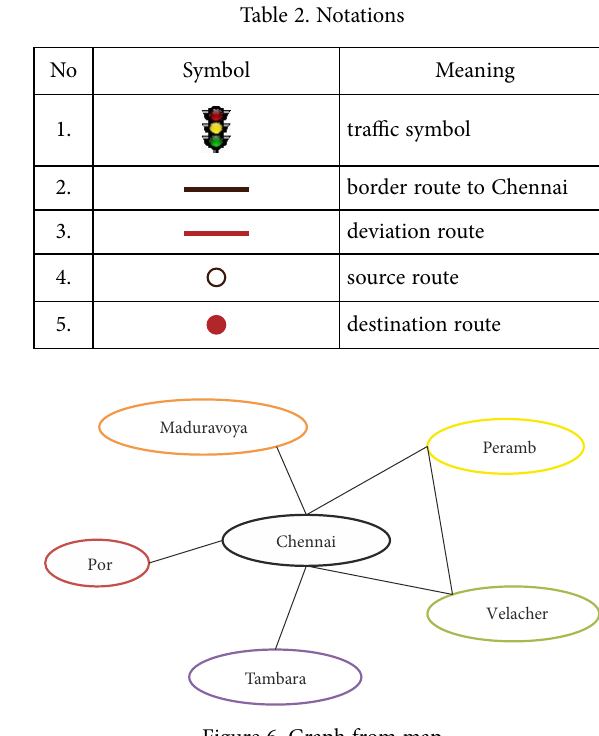
Figure 6. Graph from